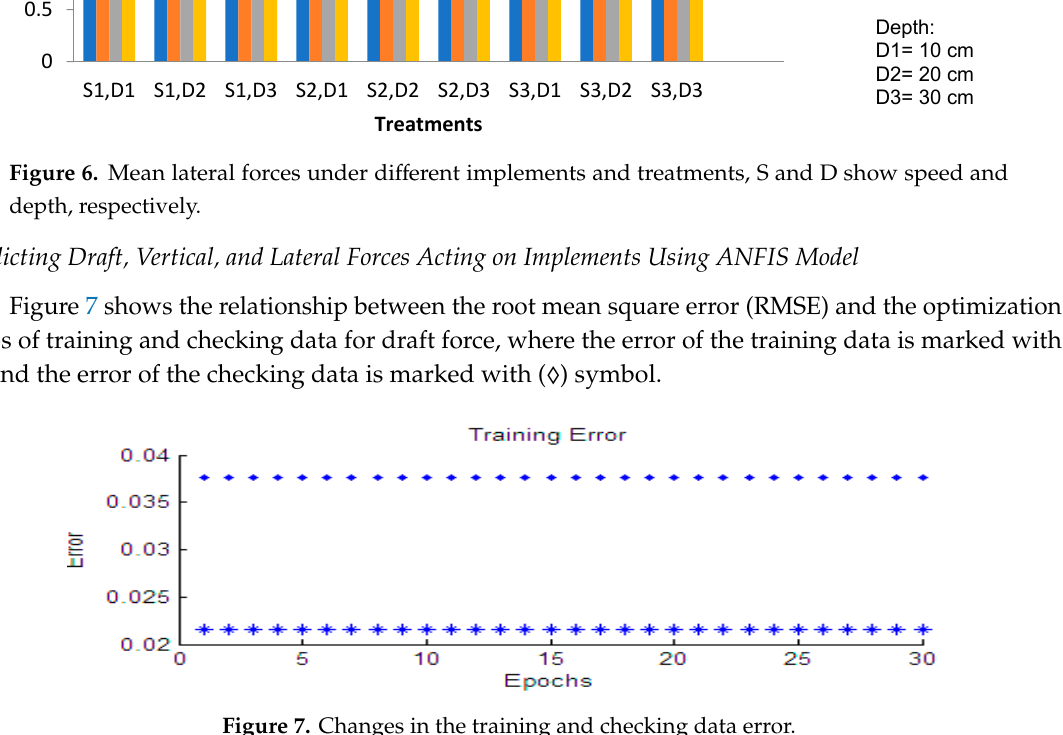
Figure 7. Changes in the training and checking data error.